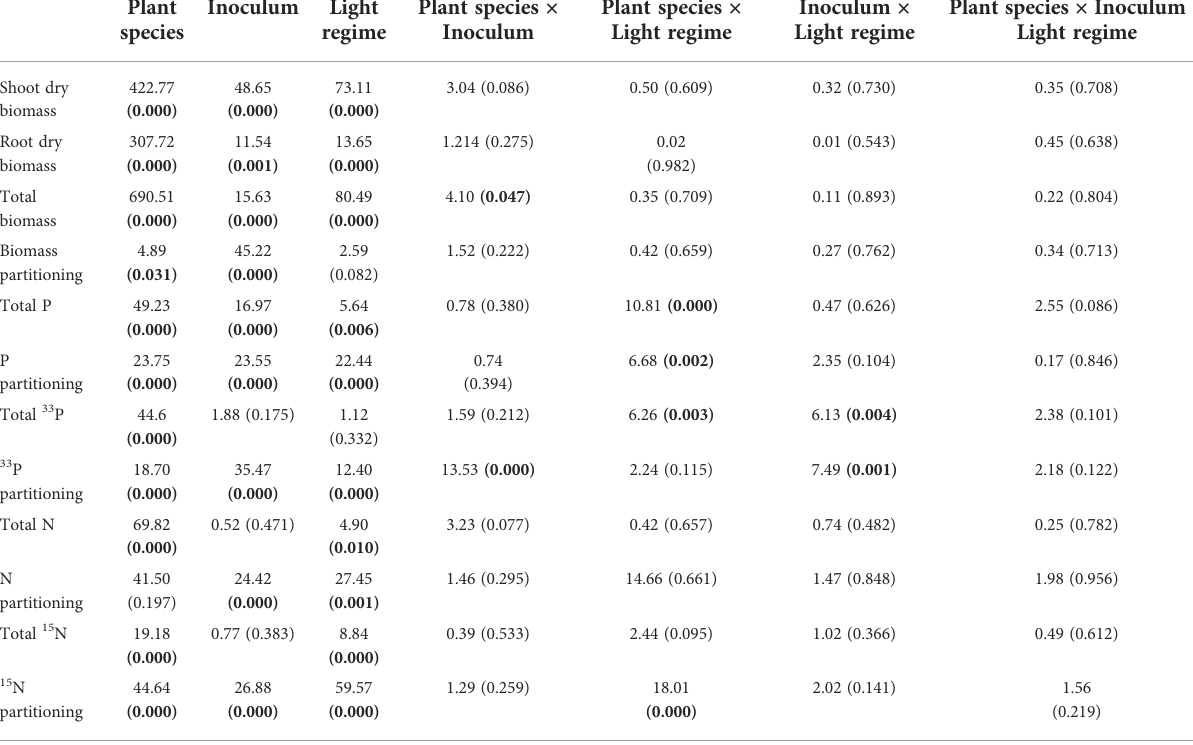
TABLE 1 Results of three-way ANOVA of the effects of light regime, mycorrhizal status, and plant species in mono system.